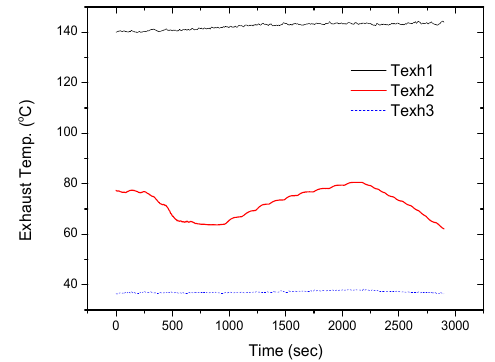
Figure 8. Temperature decrease of the exhaust gas.